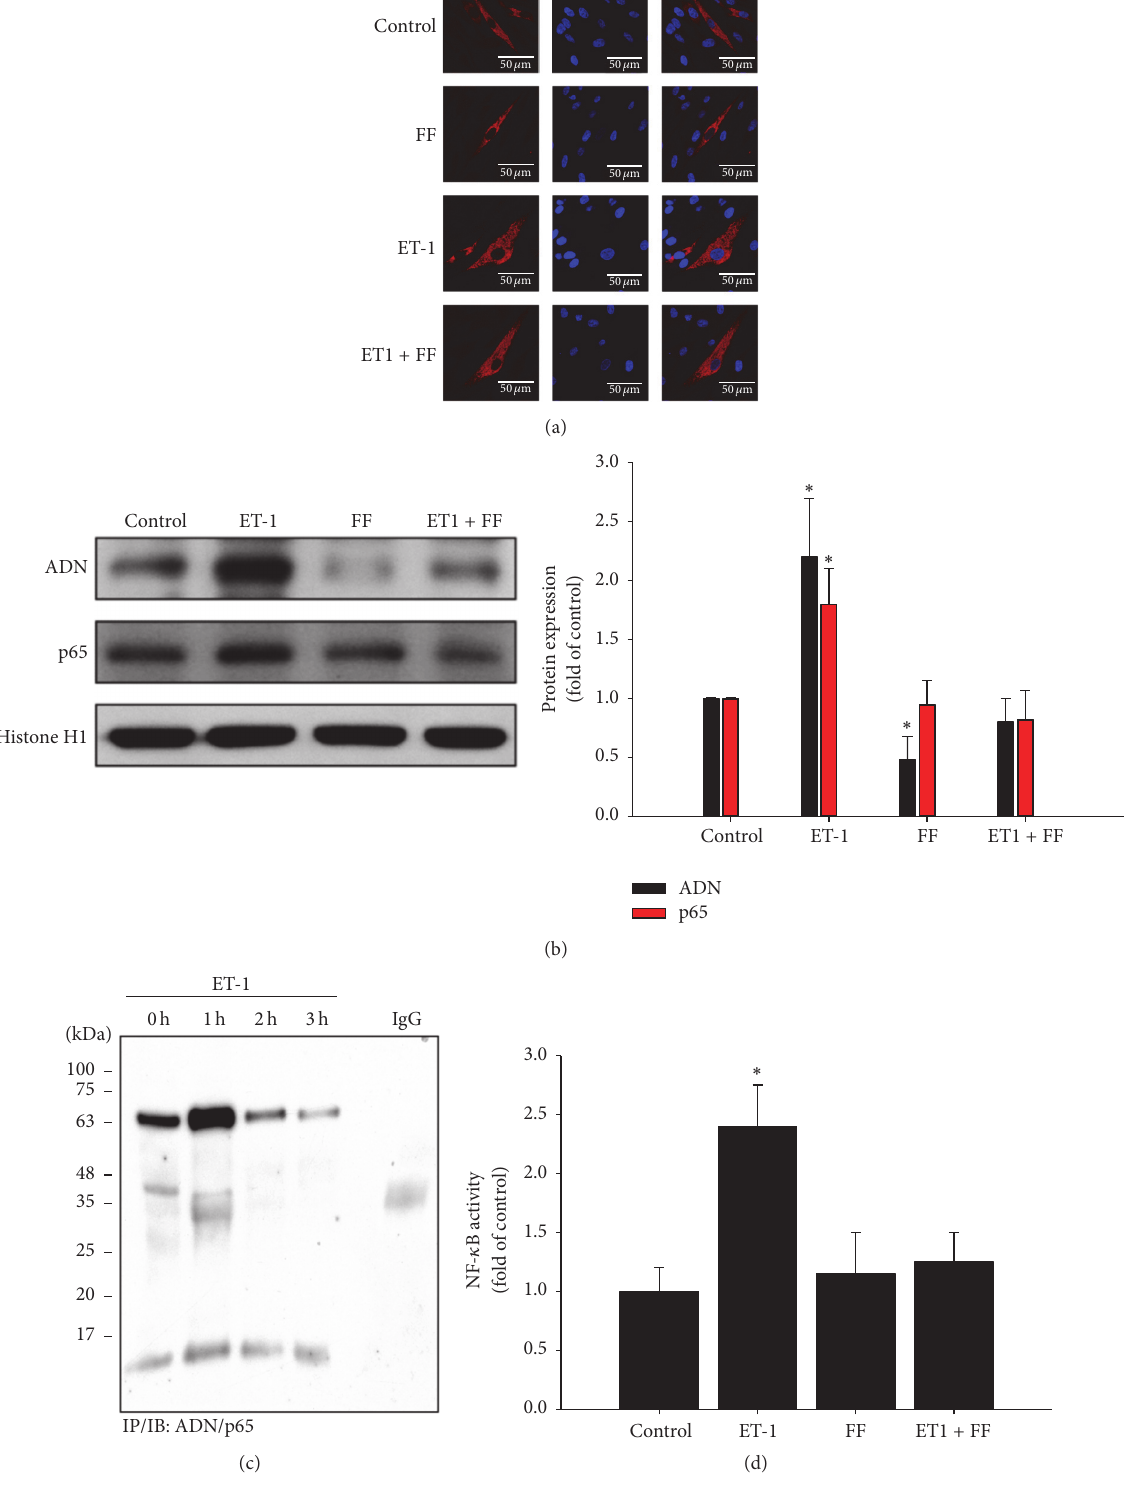
Figure 4: Fenofibrate attenuated ET-1-induced adiponectin and NF- 𝜅 B activation and DNA binding activity in cultured human cardiomyocytes. Immunofluorescence staining showed that pretreatment of HCMs with fenofibrate significantly inhibited ET-1-induced activation of adiponectin (a). The pretreatment of cells with fenofibrate (FF) inhibits adiponectin (ADN) and p65-NF 𝜅 B. Histone H1 was used as a loading control for nuclear protein (b). Fenofibrate (FF) attenuates ET-1-stimulated NF- 𝜅 B binding activity by EMSA assay (c). The summarized data (mean ± SEM) from 3 separate experiments were shown in the bar graph (d). ∗ 𝑃 < 0.05 , compared to untreated control